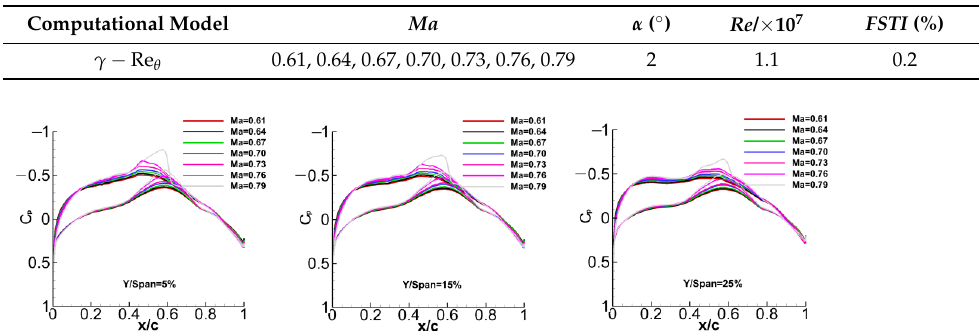
Table 5. Calculated states and methods for different Ma .